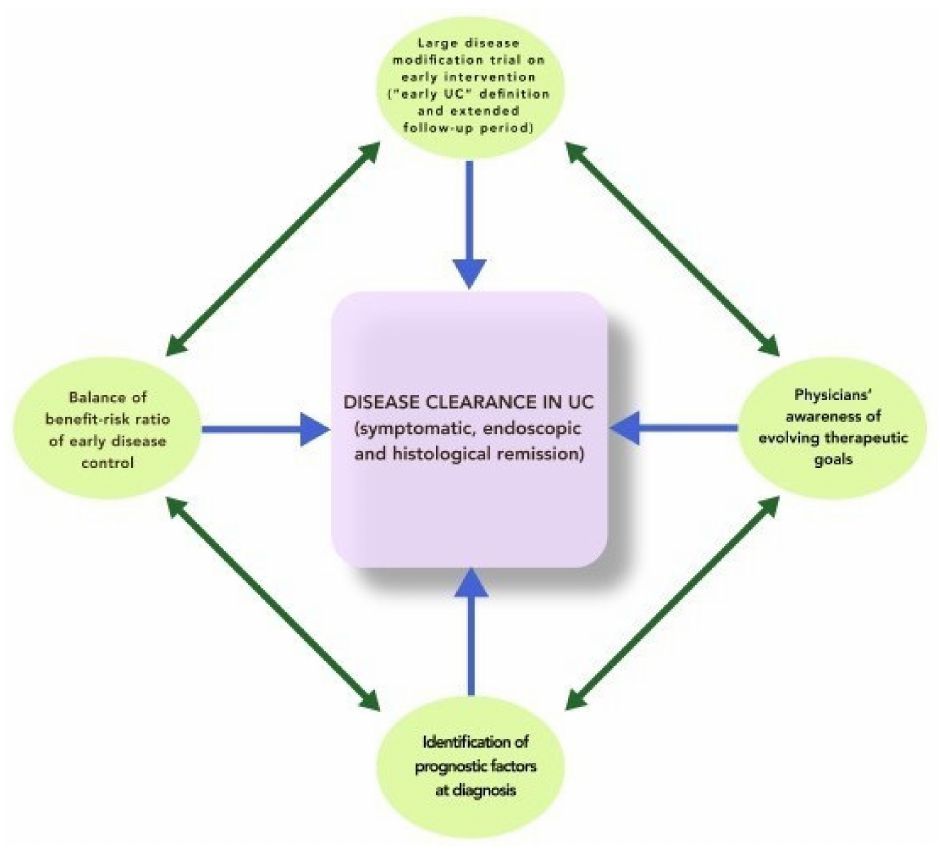
Figure 2. Combining strategies towards “disease